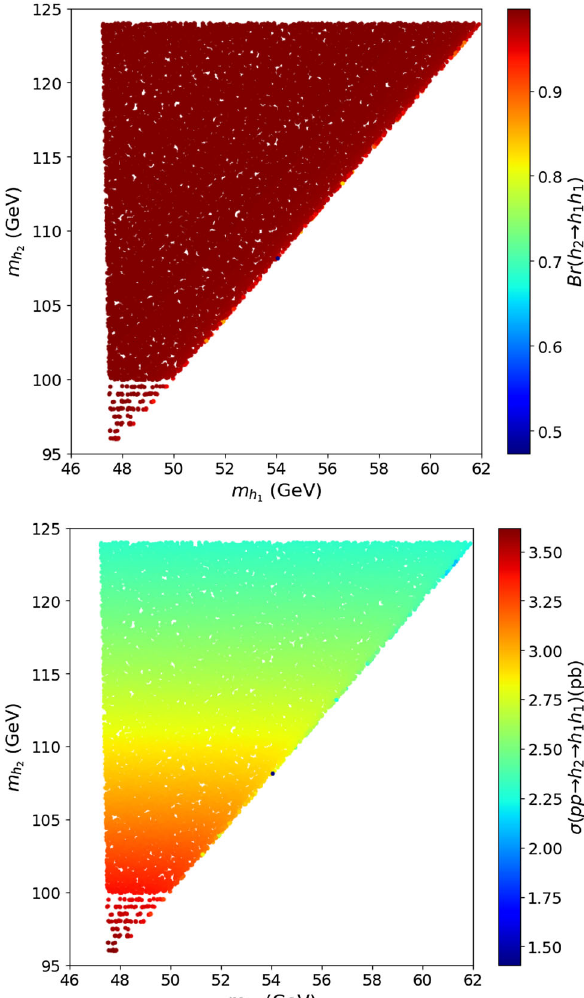
Fig. 6 The mass spectra of the h 1 , 2 Higgs bosons for BP1. The color code shows BR ( h 2 → h 1 h 1 ) (upper panel) and the σ( pp → h 2 → h 1 h 1 ) (lower panel). We set (cid:15) =